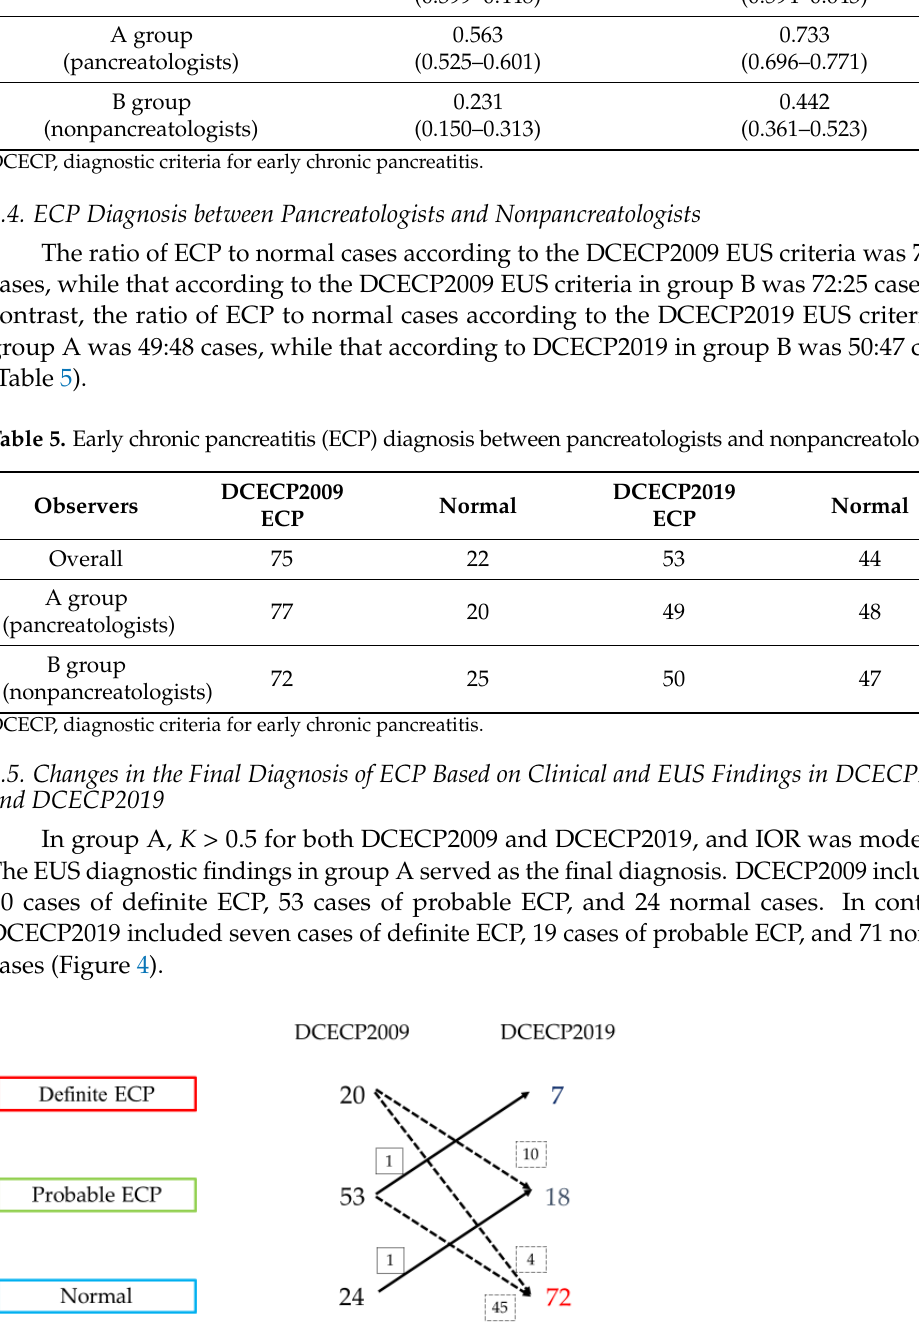
Figure 4. Changes in final diagnosis between DCECP2009 and DCECP2019, DCECP, diagnostic criteria for early chronic pancreatitis; ECP, early chronic